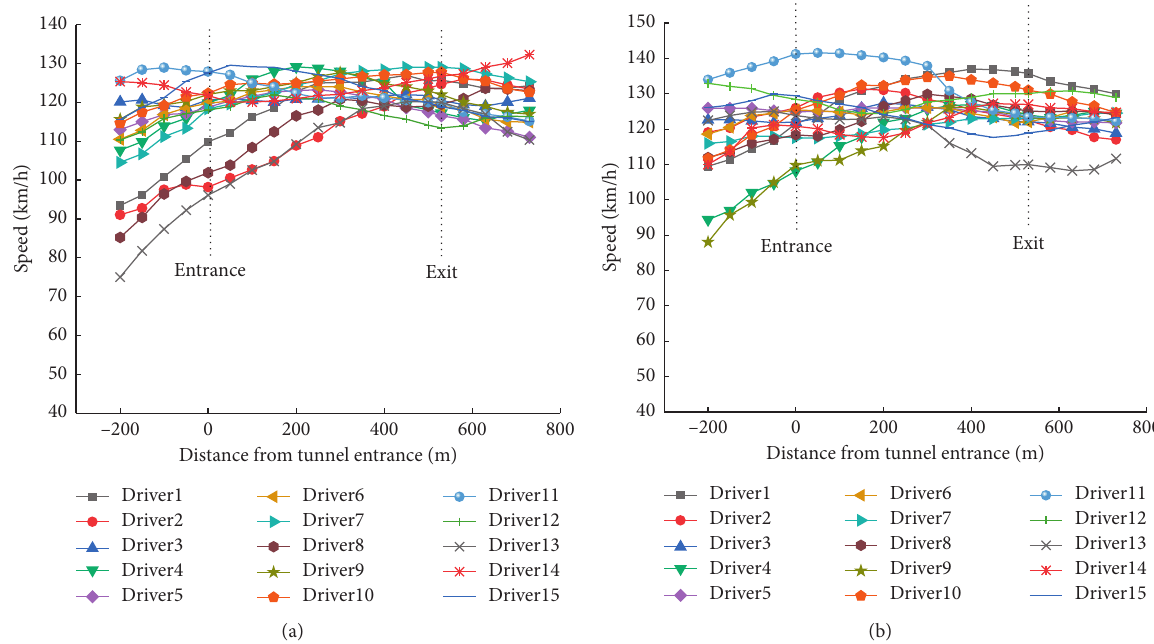
Figure 3: Operating speed change between different left lateral clearance schemes. (a) Scheme 1. (b) Scheme